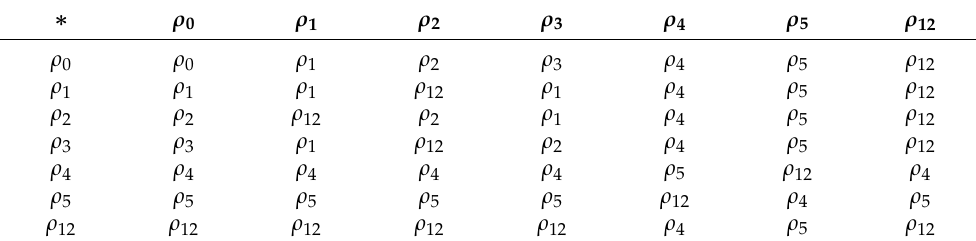
Table 2. The adjoint semigroup of BZ